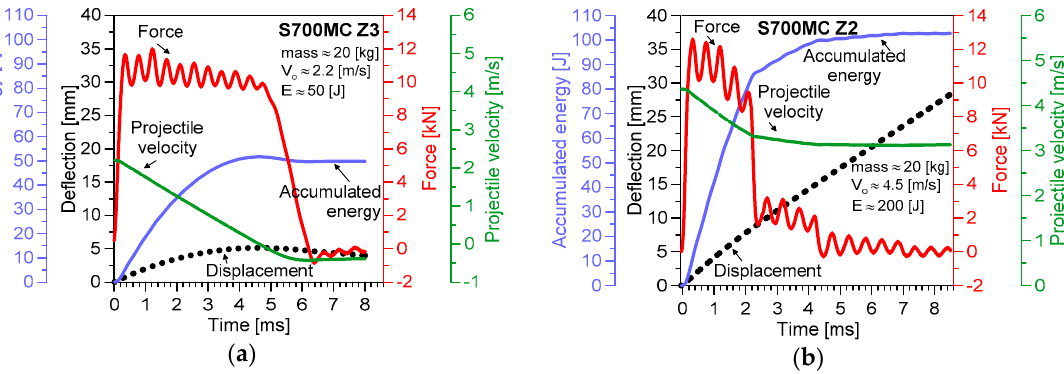
Figure 5. Variations of the Charpy test parameters for the S700MC steel (parent material) under impact energy of: ( a ) 50 J; and ( b ) 200 J.